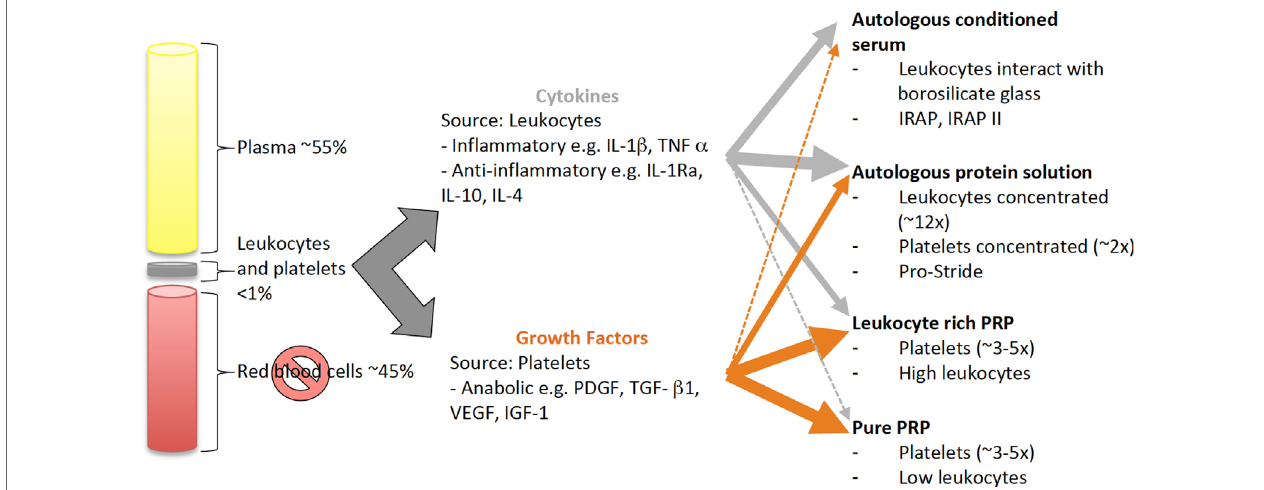
FiGURe 2 | Schematic of the source and distribution of cytokines and growth factors in blood-derived cell-based products. Cytokines and growth factors are derived from leukocytes and platelets, respectively. All blood-derived cell-based products have a combination of cytokines and growth factors, which vary in amount depending on how the products are produced. Leukocytes and platelets can be concentrated by centrifugation or filtration techniques or, the cytokines and growth factors are released during the production process, e.g., by interaction with borosilicate glass and during clot